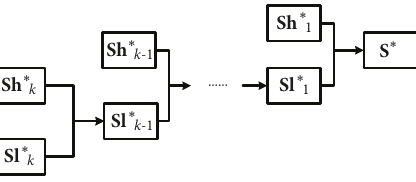
Figure 2: The process of